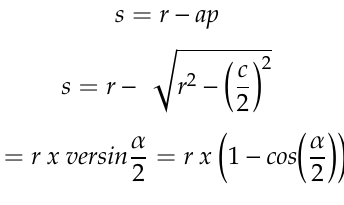
Figure 3. Sagitta of the circular arch described by the coverage of the drone.